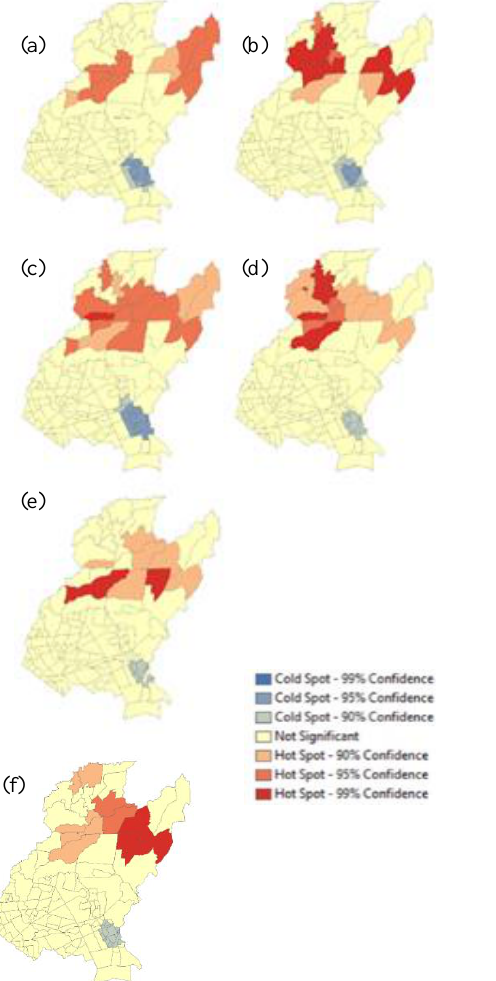
Figure 4. a) Six-year average rainfall and (b) six-year average land surface temperature (c) elevation of Quezon City from 2010 to